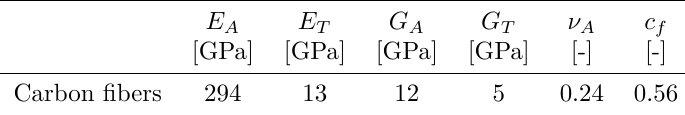
Table 1. Material properties of carbon fibers and its volume fraction in